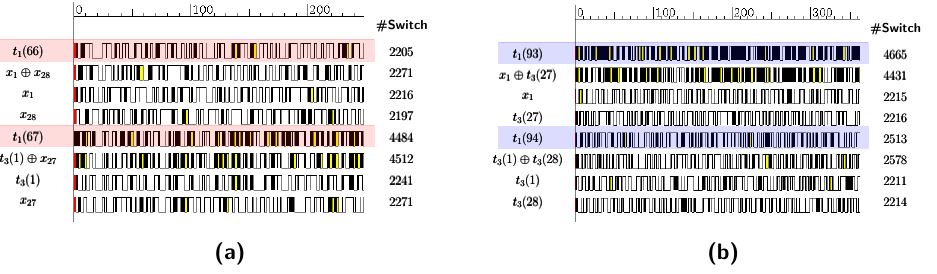
Figure 5: Timing diagrams for internals in (a) t 1 (66), t 1 (67), and (b) t 1 (93), t 1